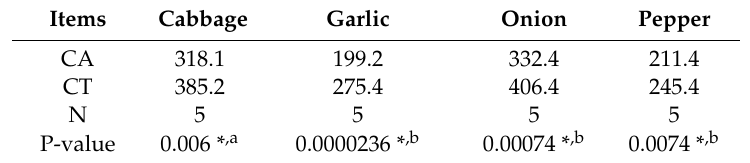
Table A3. A one tailed paired t-test for the average irrigation water use for variety of vegetables.